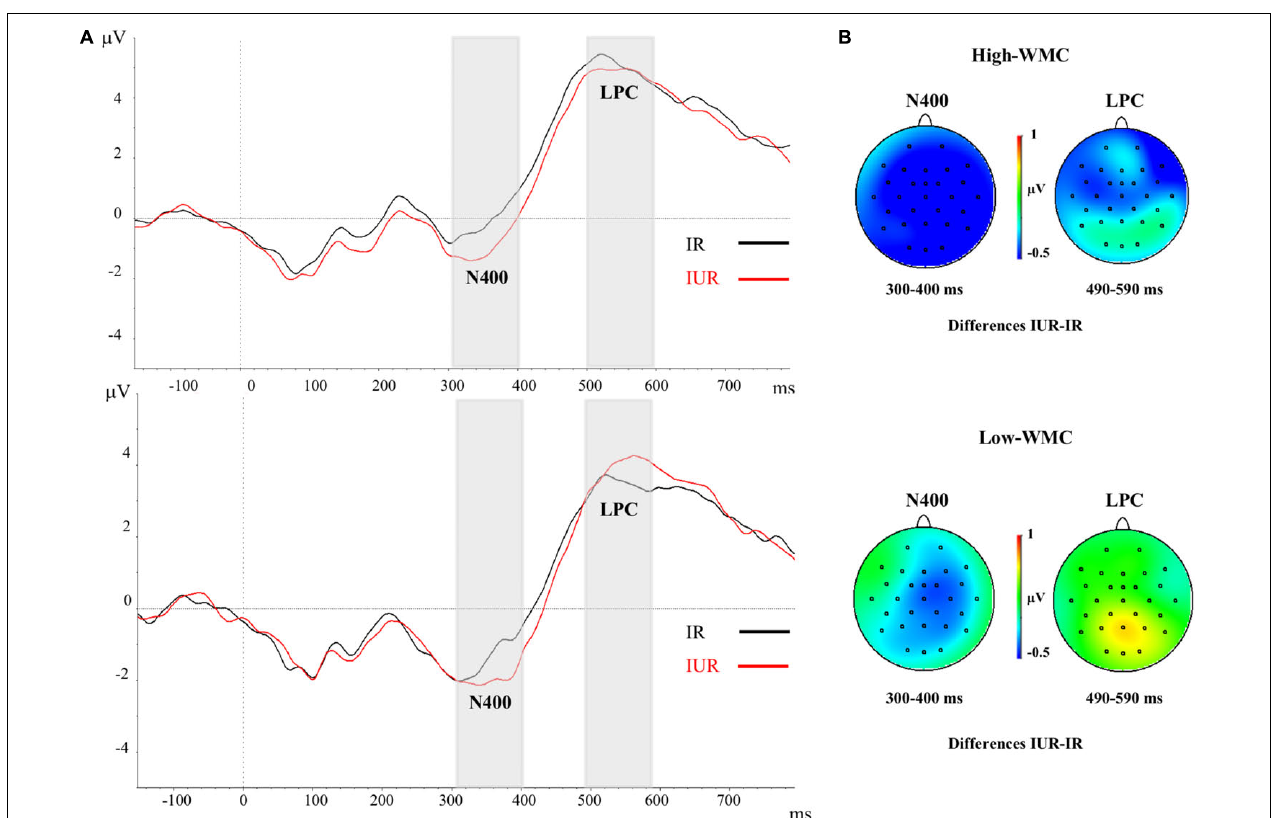
FIGURE 3 | (A) Grand-averaged voltage data (in µ V) in the Immediate Masking condition as a function of WMC and Prime-Target Relatedness (Related-R, black line, vs. Unrelated-NR, red line). As statistical analyses did not yield significant effects of the laterality and caudality factors, voltages were collapsed across the nine fronto-central and centro-parietal electrode sites (FC1/FC2, C3/C4, P3/P4, FCz, Cz, Pz). The analyzed epoch lasted from 150 ms before the onset of the target to 700 ms after target onset. Negative potentials are plotted downwards. Vertical gray shadings above the X -axes indicate the 300–400 ms (N400) and 490–590 ms (LPC) time windows used for statistical analysis in this and the other ERP figures. (B) Topographic voltage maps across the 29 electrode sites, displaying the ERP priming differences (unrelated minus related trials) in the immediate masking condition. The N400 ERP component with fronto-central and centro-parietal topography showed a global semantic priming effect in both WMC groups. No reliable LPC ERP effect was observed for neither High-WMC nor Low-WMC participants. IR, Immediate Related; IUR, Immediate